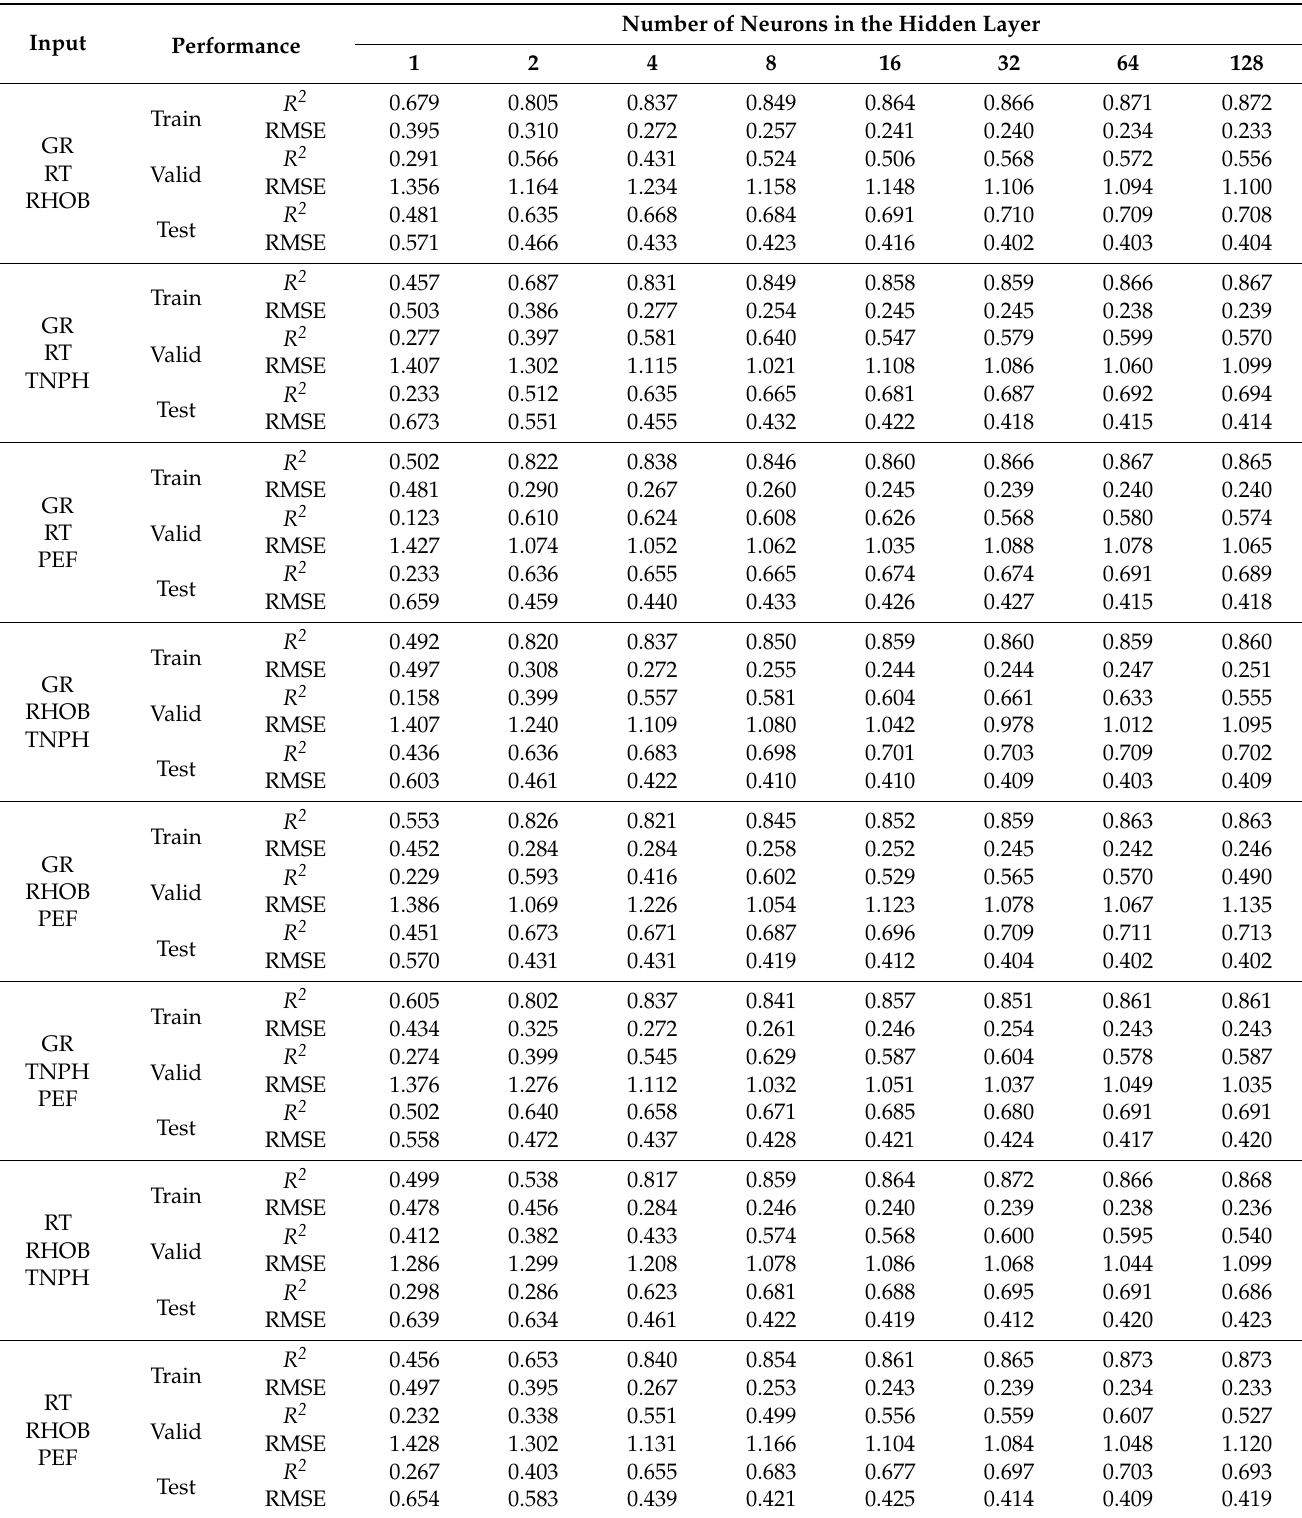
Table A3. Performance for generating synthetic Vp using three input